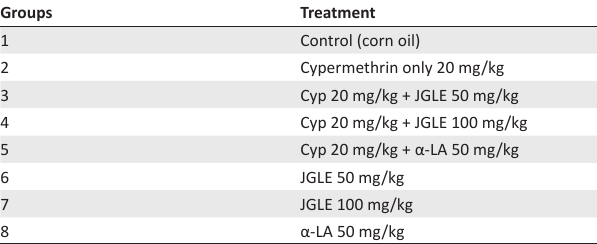
TABLE 1: Drug administration. Groups